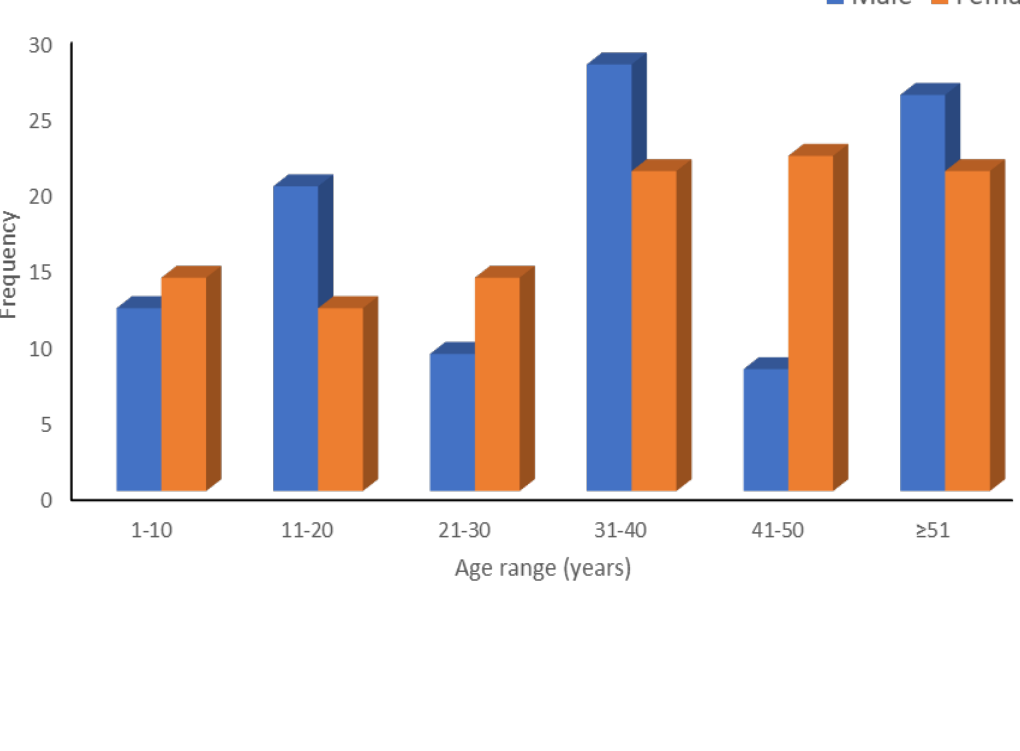
Figure 1. Frequency of throat pathogens’ carriers in relation to age and sex